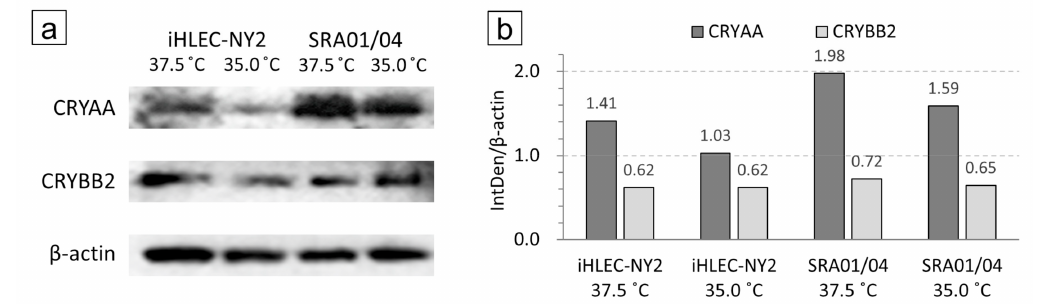
Figure 8. iHLEC-NY2 and SRA01 / 04 cell Western blotting results. ( a ) Immunostaining results of CRYAA and CRYBB2 in cells cultured at 37.5 ◦ C and 35.0 ◦ C. ( b ) The integrated density (IntDen) of each captured band was analyzed and corrected with β -actin.